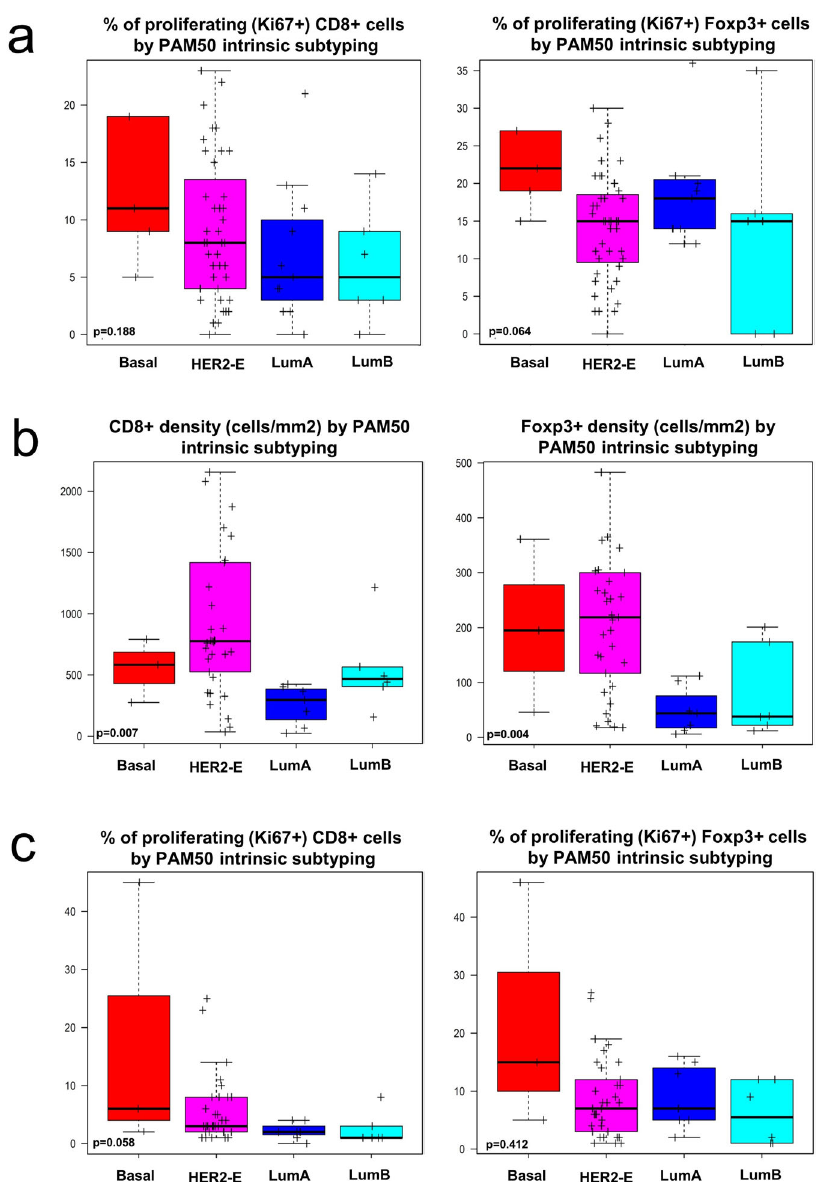
Fig. 3 Immune cell density according to intrinsic subtype. a Boxplots of the proportion of proliferating immune cells (CD8 + and Foxp3 + ) at baseline according to baseline intrinsic subtyping. b Boxplots of immune cells densities (CD8 + and Foxp3 + ) at day 15 according to baseline intrinsic subtyping. c Boxplots of the proportion of proliferating immune cells (CD8 + and Foxp3 + ) at day 15 according to baseline intrinsic subtyping. Boxplot legend: centre line: median; bounds of box: interquartile range (IQR); whiskers: highest and lowest value excluding outliers (Q3 + 1.5*IQR to Q1 – 1.5*IQR); markers beyond the whiskers: potential